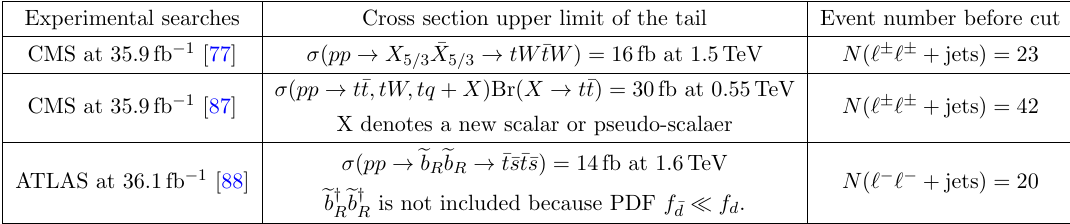
Table 7. The experimental results of the SSDL (cid:12)nal states at the 13 TeV